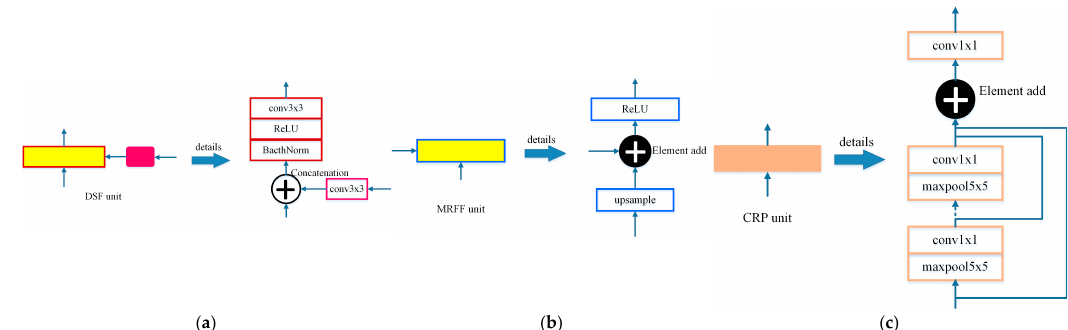
Figure 3. ( a ) DSF unit, ( b ) MRFF unit, and ( c ) CRP unit. In each illustration, the left block is the representation of the module in Figure 2 and its detailed structures are on the right. The yellow blocks denote the feature fusion modules. The red edge denotes the fusion of different types of features with the magenta block of the adaptive convolution and the blue edge denotes the fusion of features with different resolutions. The CRP unit is represented as the orange block. Depth–Semantics-Fusion (DSF) unit. The DSF unit, as shown by the dash-dotted